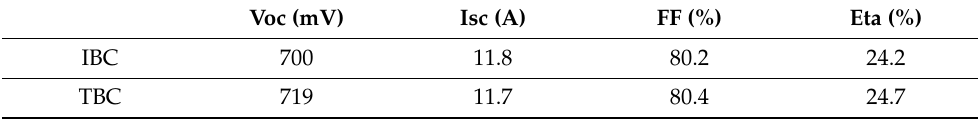
Table 4. Average IV data for IBC and TBC processes for 50 solar cells each.